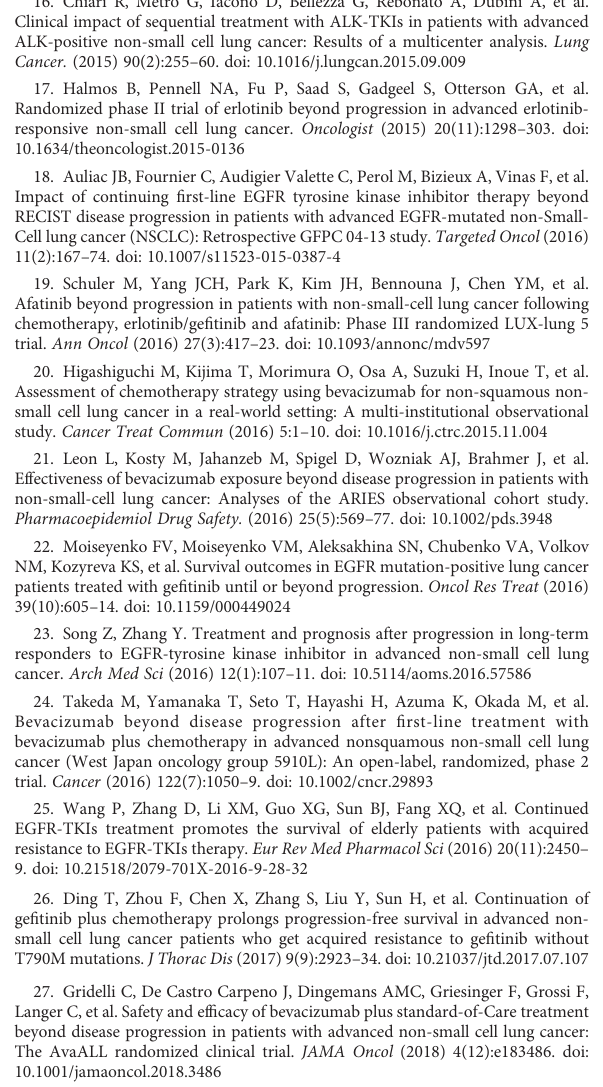
SUPPLEMENTARY FIGURE 1 Forest plot of subgroup analysis of association between post progression progression-free survival and (A) classi fi cation of treatment beyond progression (TBP) drugs. (B) treatment of the non-TBP group. (C) region.